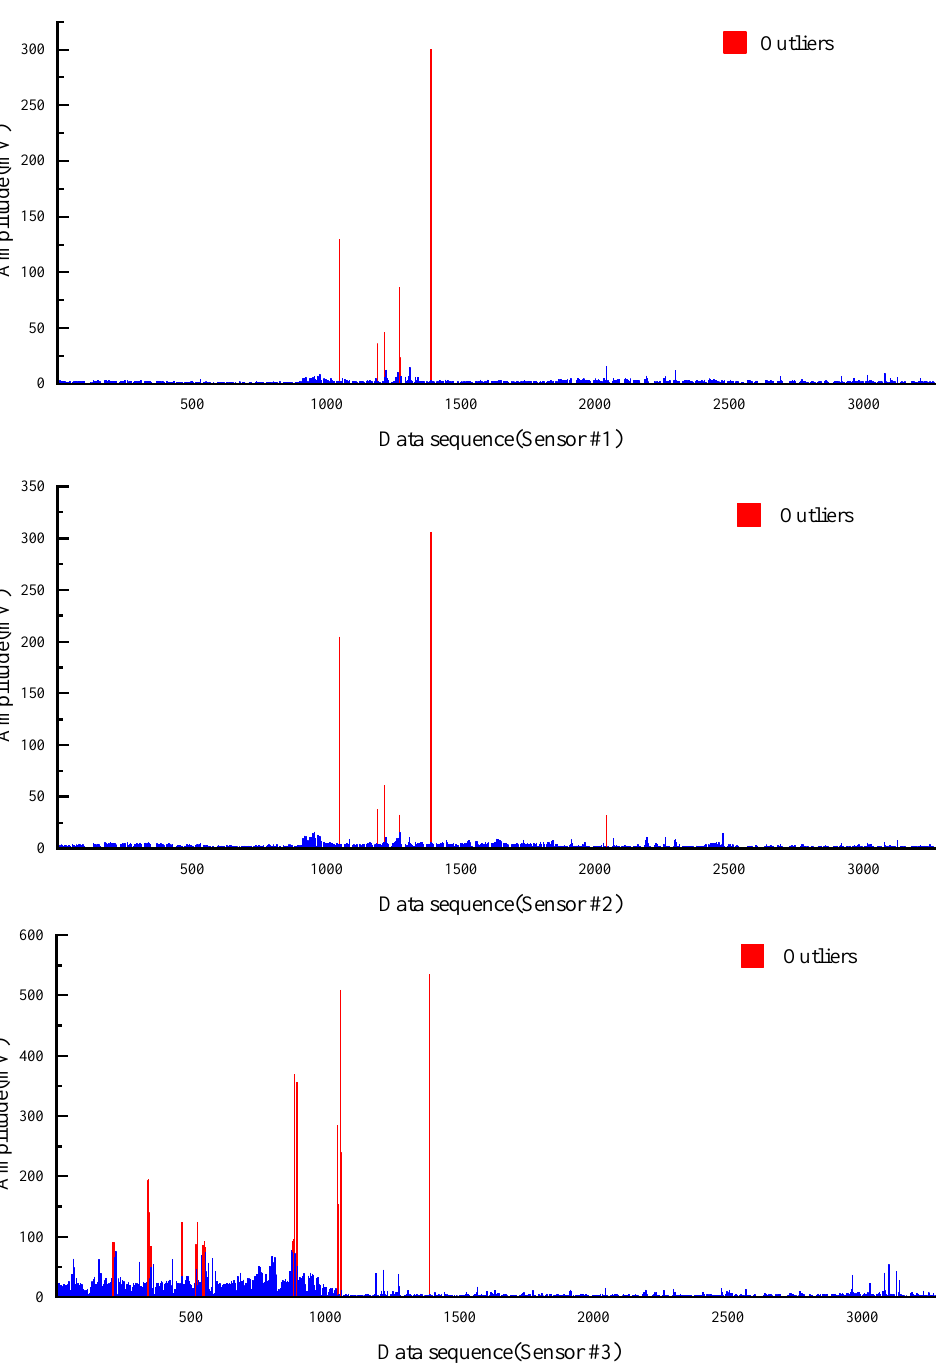
Figure 5. Original data of all 3 sensors.